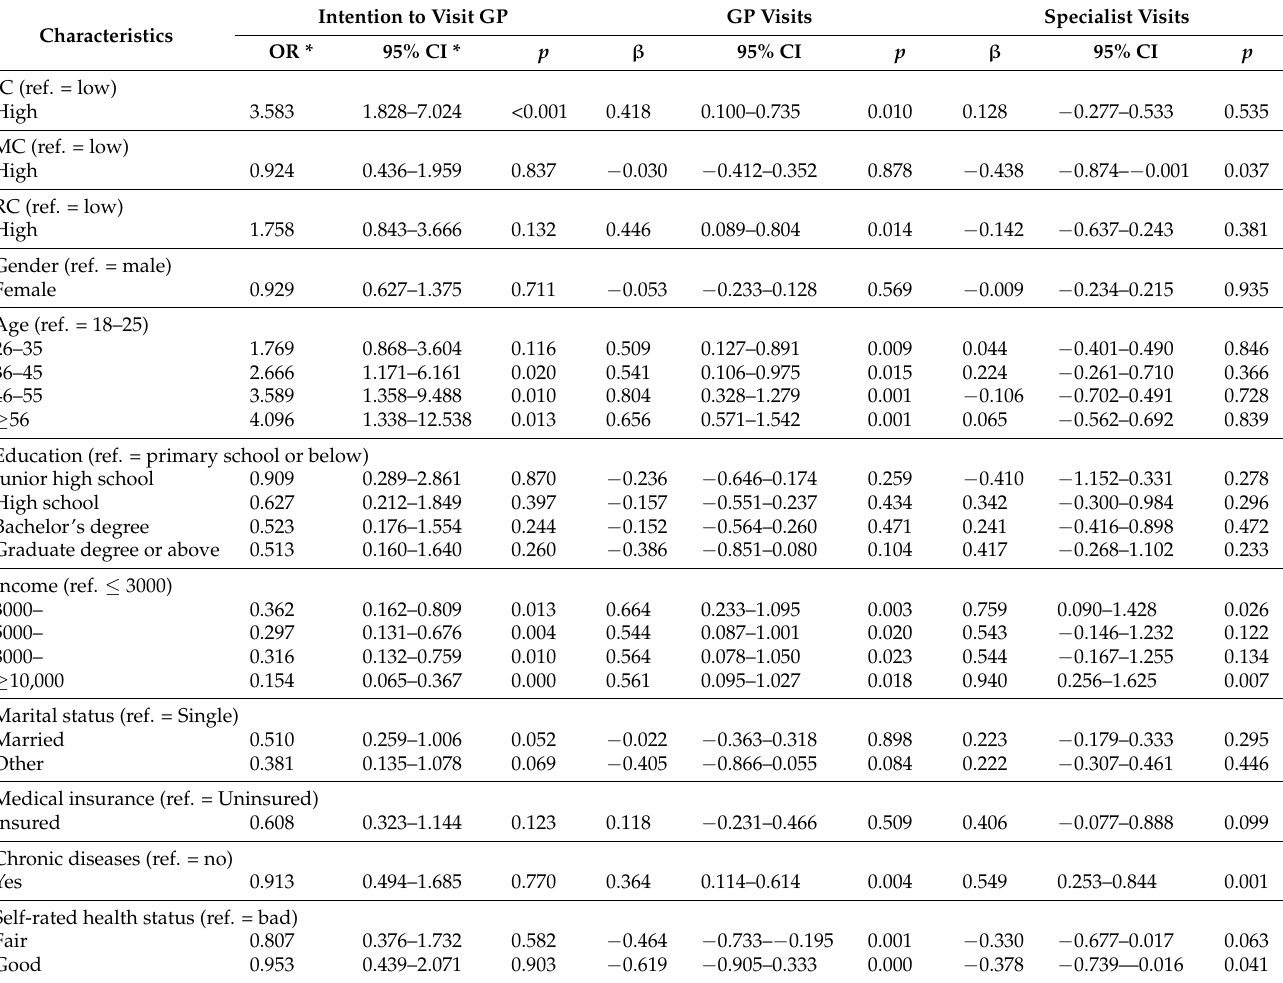
Table 4. Prediction of COC for visiting intention, frequency of GP and specialist